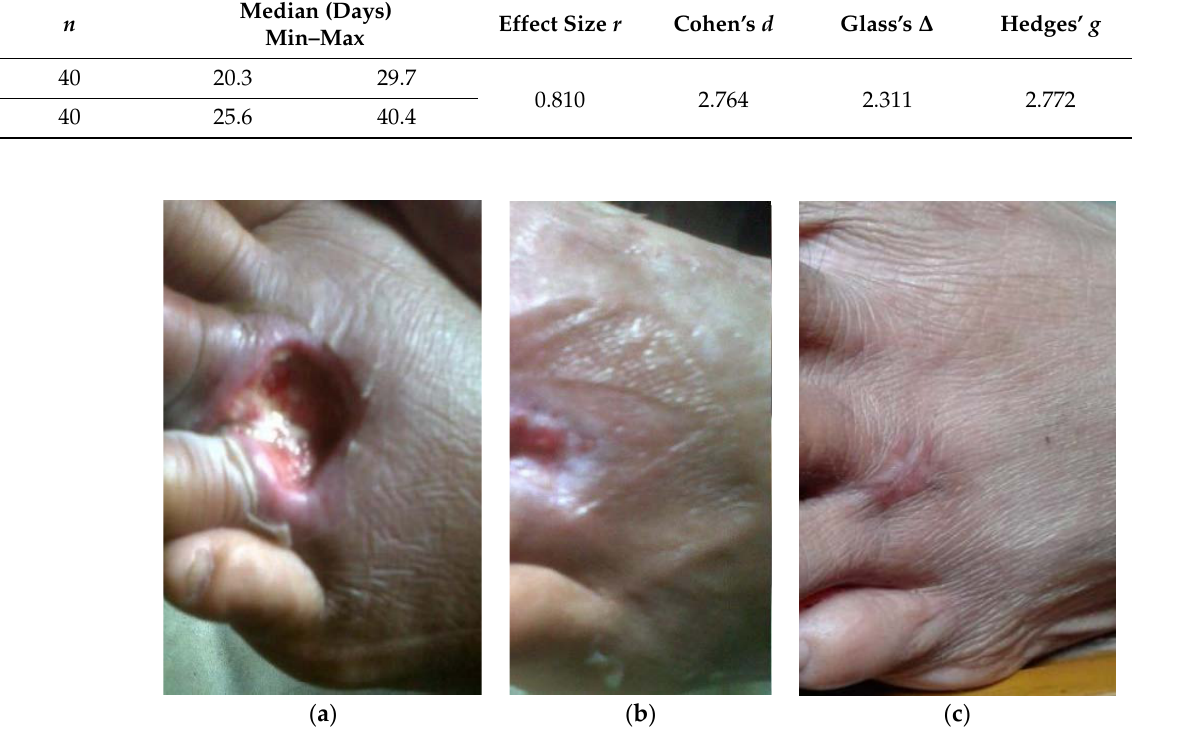
Figure 2. An ulcer photograph of a patient (age = 49) located on the left foot’s central aspect. This ulcer had remained open for one week. The patients received a standard diabetic neuropathic foot ulcers treatment and a complementary VWT intervention. ( a ). Day 0 before treatment (wound area = Table 1. Characteristics of patients who participated in this study. Table 4. Wound closure area between